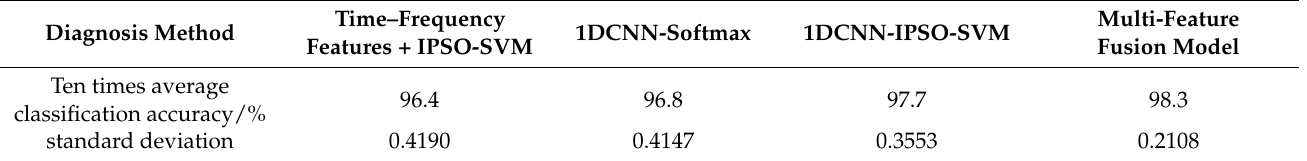
Table 7. Average accuracy and standard deviation of the four models.